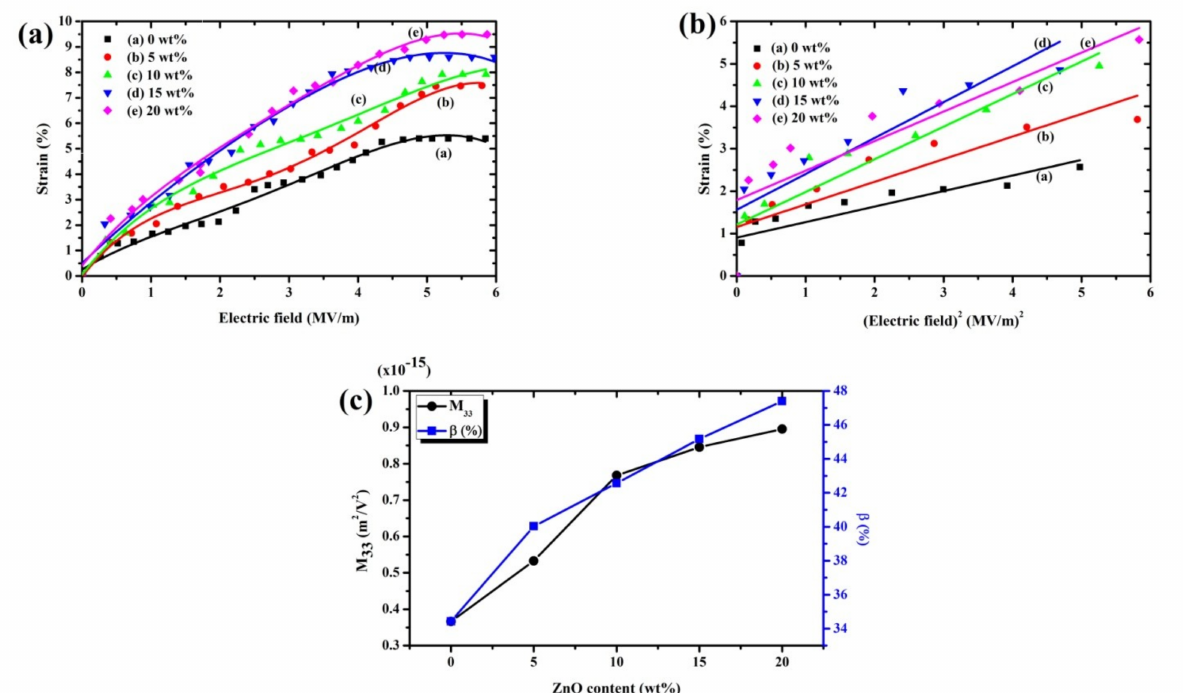
Figure 10. The longitudinal strain in the P(VDF-HFP)/ZnO composites nanofibers at 1 Hz: ( a ) strain as a function of the electric field; ( b ) strain as a function of E 32 ; and ( c ) the effect of the ZnO content on the electrostrictive coefficient and the absolute β